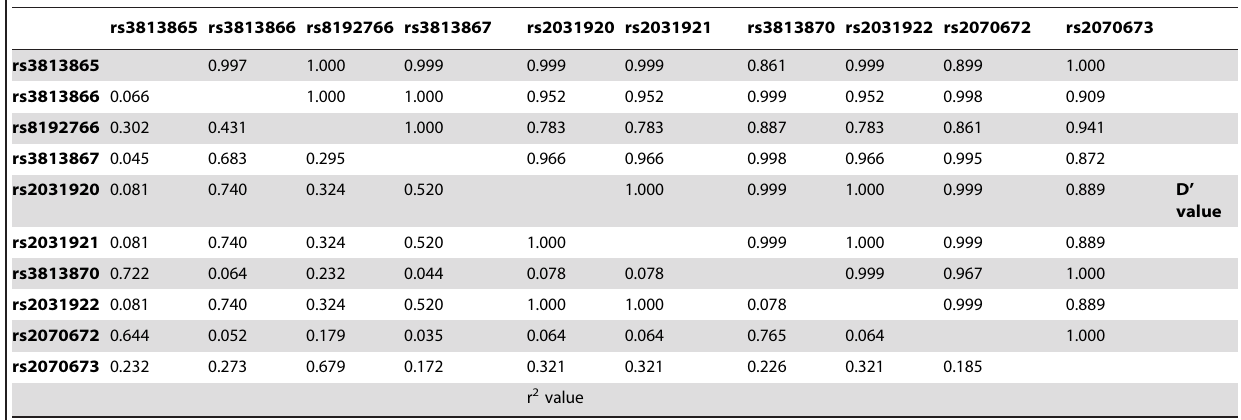
Table 5. Pairwise polymorphisms LD analysis.